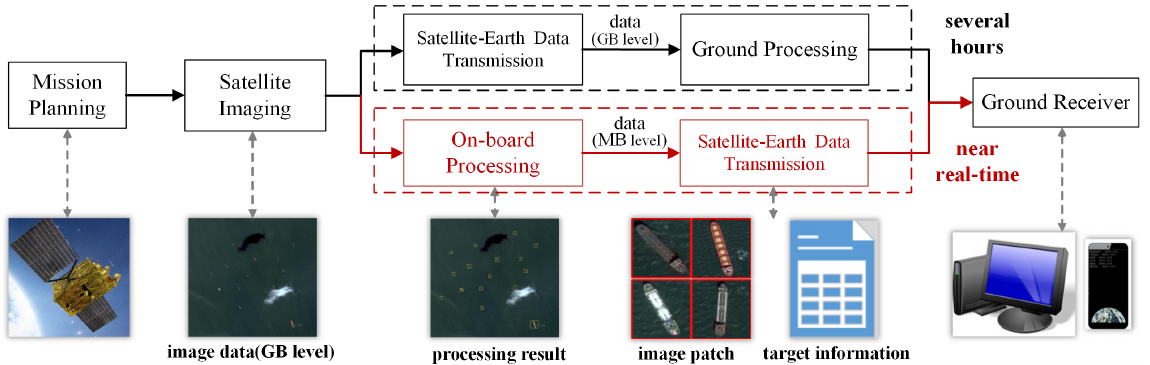
Figure 1. The comparison between ground processing and on-board processing. The black line is the traditional ground processing flow, and the red line is the on-board processing